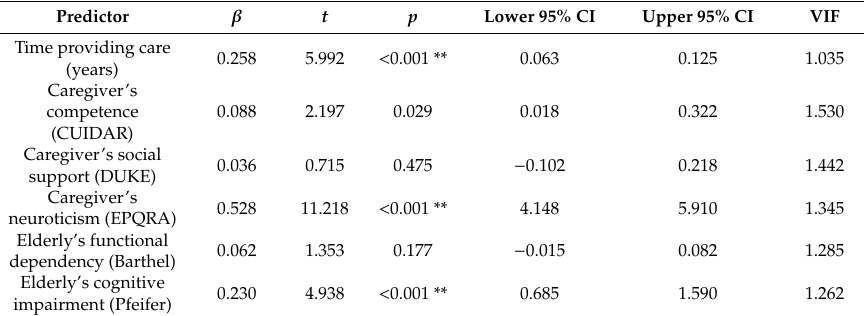
Table 4. Prediction of burden in informal female